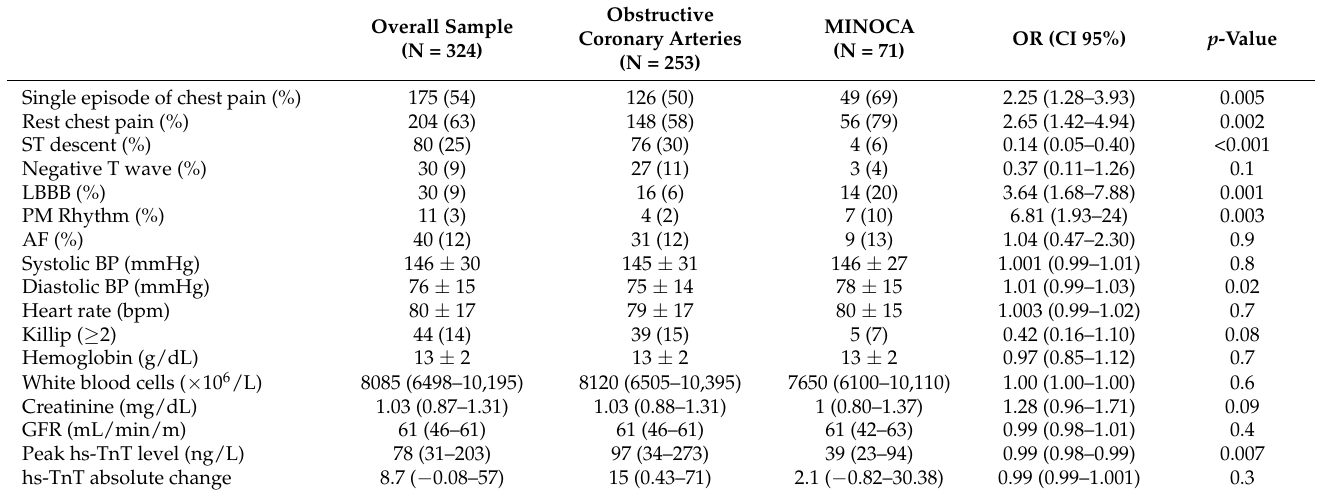
Table 2. Episode characteristics. Univariate analysis: association with MINOCA diagnosis.